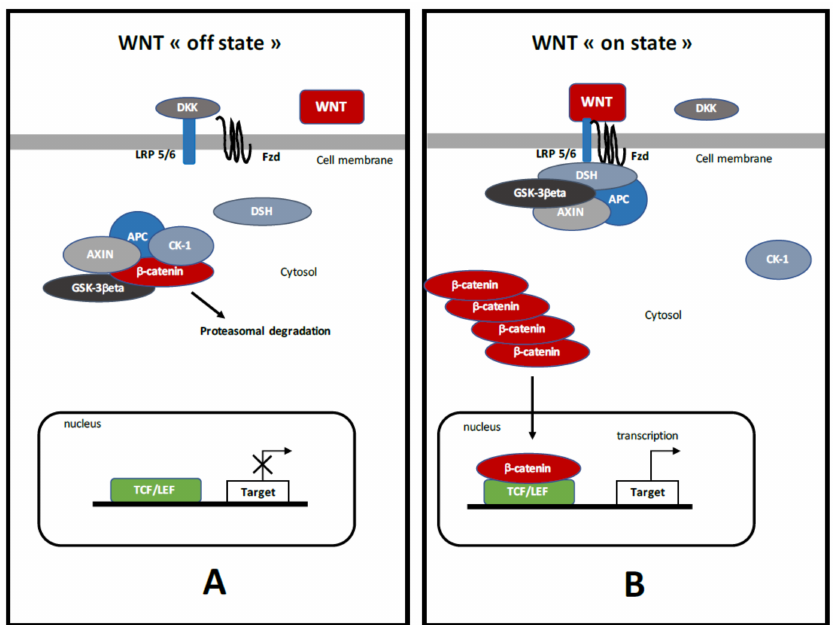
Figure 1. The canonical WNT/ β -catenin pathway. ( A ) Under physiological circumstances, the WNT “off state”, the cytosolic β -catenin is bound to its destruction complex, consisting of adenomatous polyposis coli (APC), AXIN and glycogen synthase kinase-3 β (GSK-3 β ). After CK-1 phosphorylates on Ser45 residue, β -catenin is further phosphorylated on Thr41, Ser37, and Ser33 residues by GSK-3 β . Then, phosphorylated β -catenin is degraded into the proteasome. Therefore, the cytosolic level of β -catenin is kept low in the absence of WNT ligands. If β -catenin is not present in the nucleus, the T-cell factor/lymphoid enhancer factor (TCF/LEF) complex cannot activate the target genes. Dickkopf (DKK) can inhibit the WNT/ β -catenin pathway by binding to WNT ligands or low-density lipoprotein receptor-related protein 5/6 (LRP 5/6). ( B ) When WNT ligands bind to both Frizzled (FZD) and LRP 5/6, the WNT “on state”, Disheveled (DSH) is recruited and phosphorylated by FZD. Phosphorylated DSH in turn recruits AXIN, which dissociates the β -catenin destruction complex. Therefore, β -catenin escapes from phosphorylation and subsequently accumulates in the cytosol. The accumulated cytosolic β -catenin goes into the nucleus, where it binds to TCF/LEF and activates the transcription of target